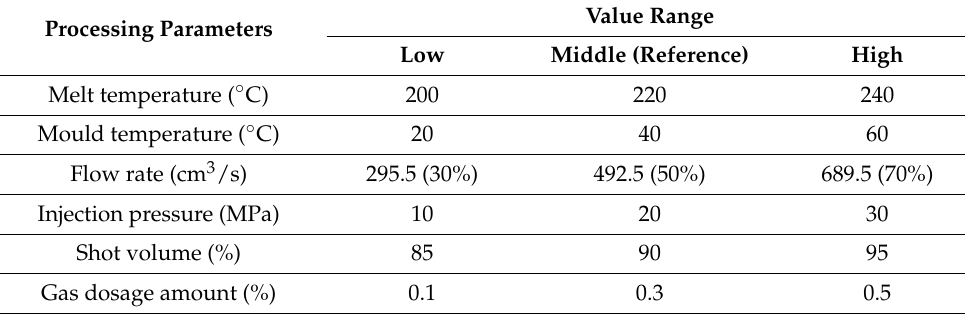
Table 1. Processing conditions.